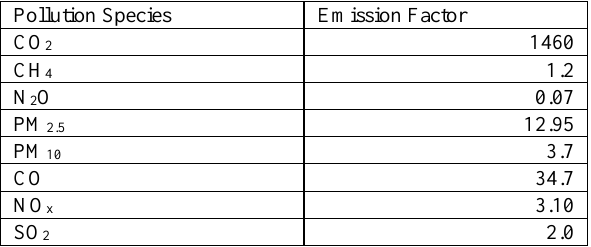
Table 1. Emission Factors (Source: Gadde, 2009)